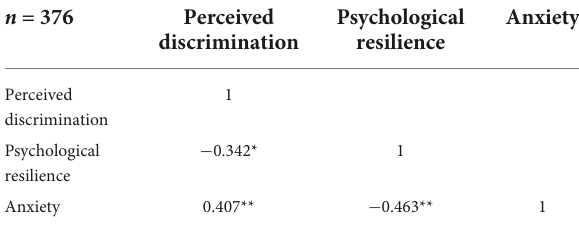
TABLE 3 Bivariate pearson correlation